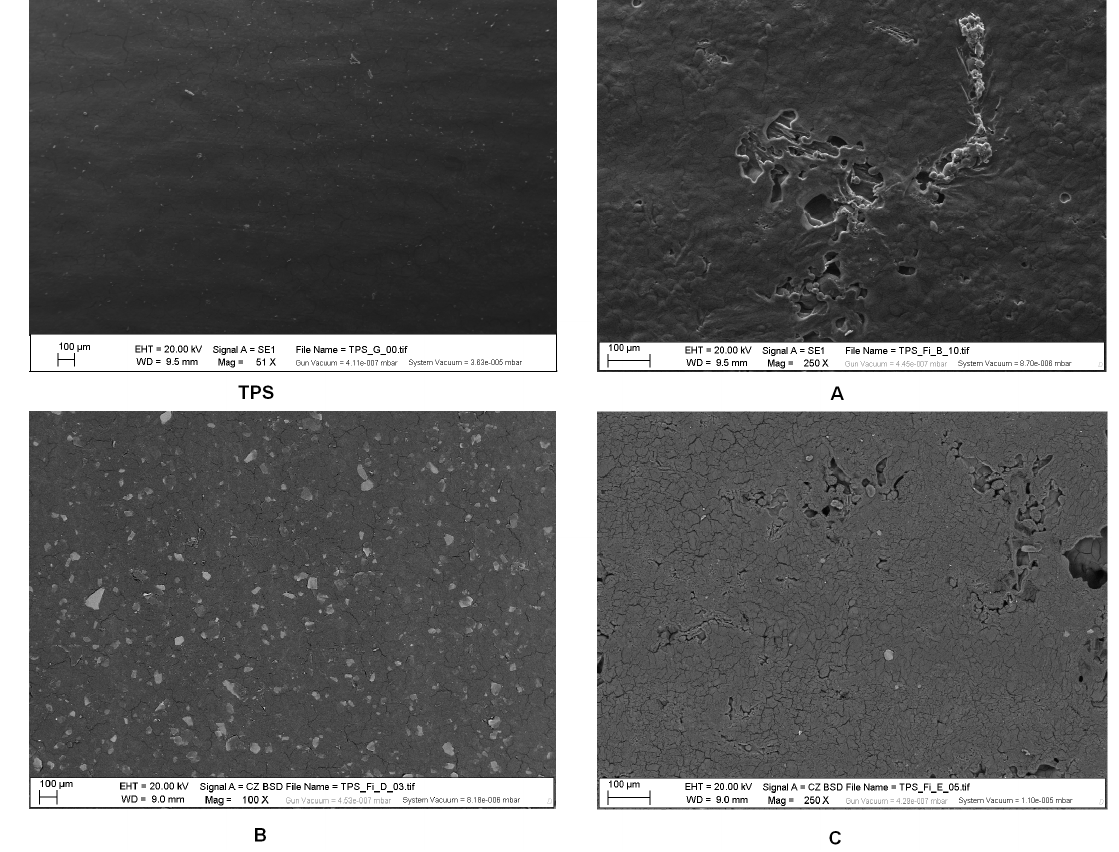
Figure 8. SEM images of thermoplastic starch (TPS) and its composites with dry nopal fibers (type A, B and C, respectively).